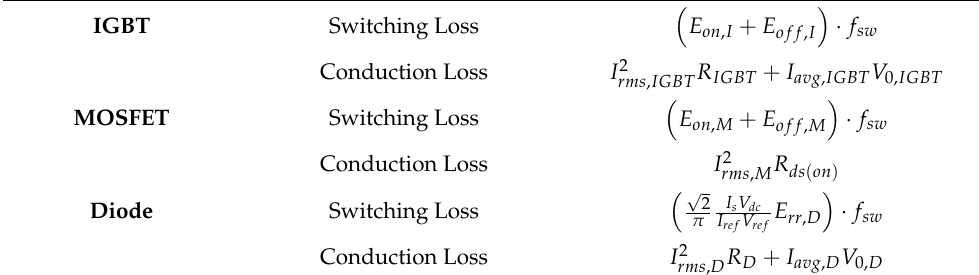
Figure 1. Typical two-stage, single-phase PV converter topology [41]. Table 1. Semiconductor power